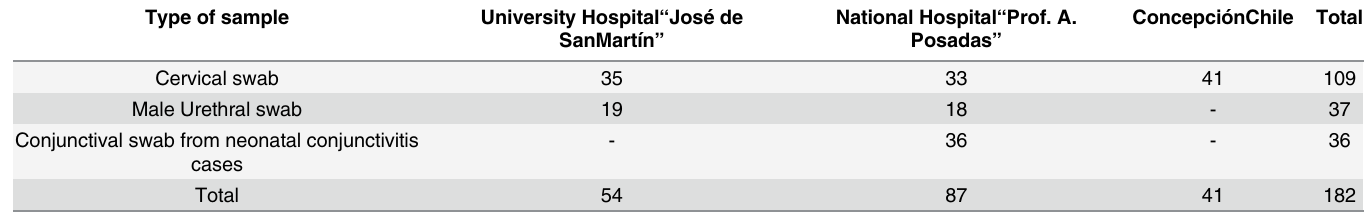
Table 1. Type and origin of samples included in this